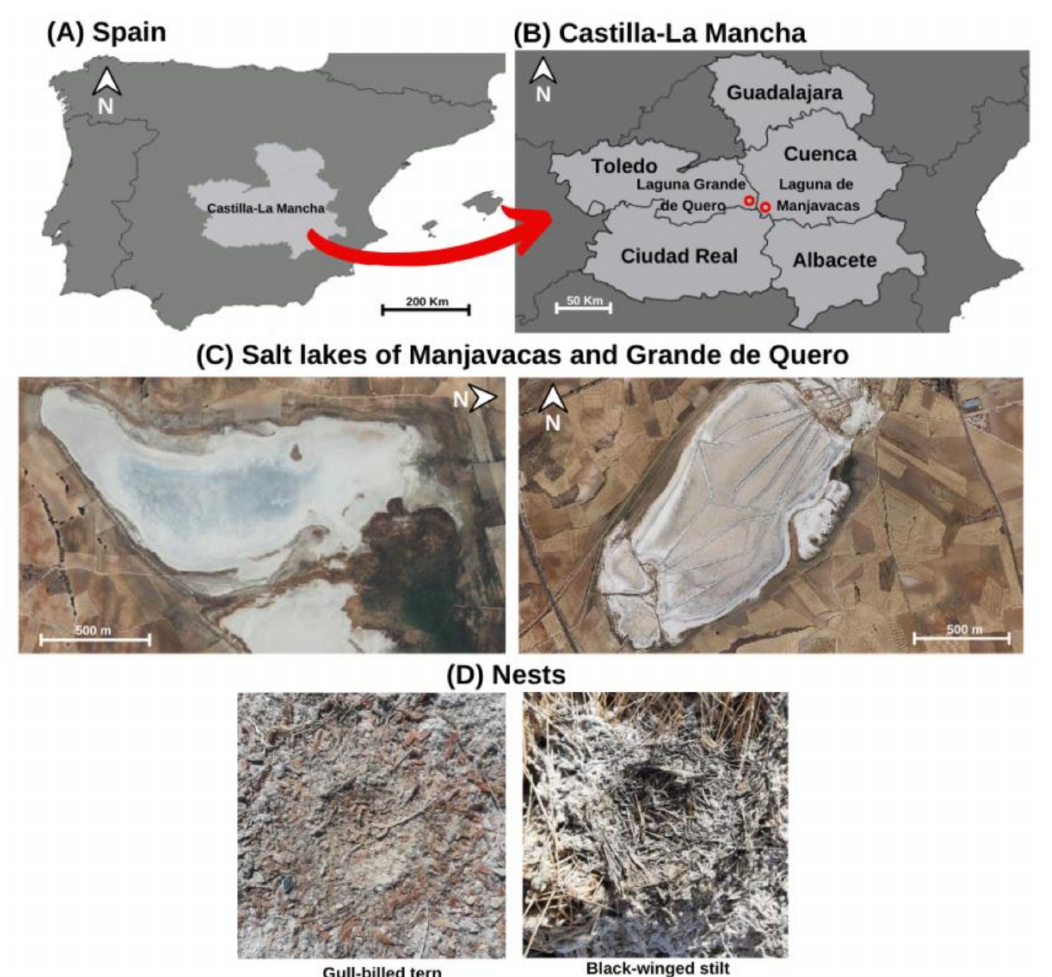
Figure 1. Maps showing the selected study area where the nests of the wetland colonial birds were examined to find plastic debris. ( A ) Castilla-La Mancha, located in Central Spain; ( B ) the two studied salt lakes (Manjavacas and Grande de Quero) located in Cuenca and Toledo; ( C ) aerial view of the studied salt lakes; ( D ) nest details of the two studied